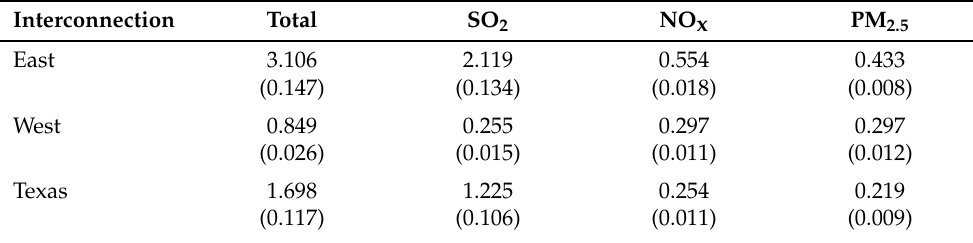
Table 2. Marginal expected deaths per TWh of electricity consumption.